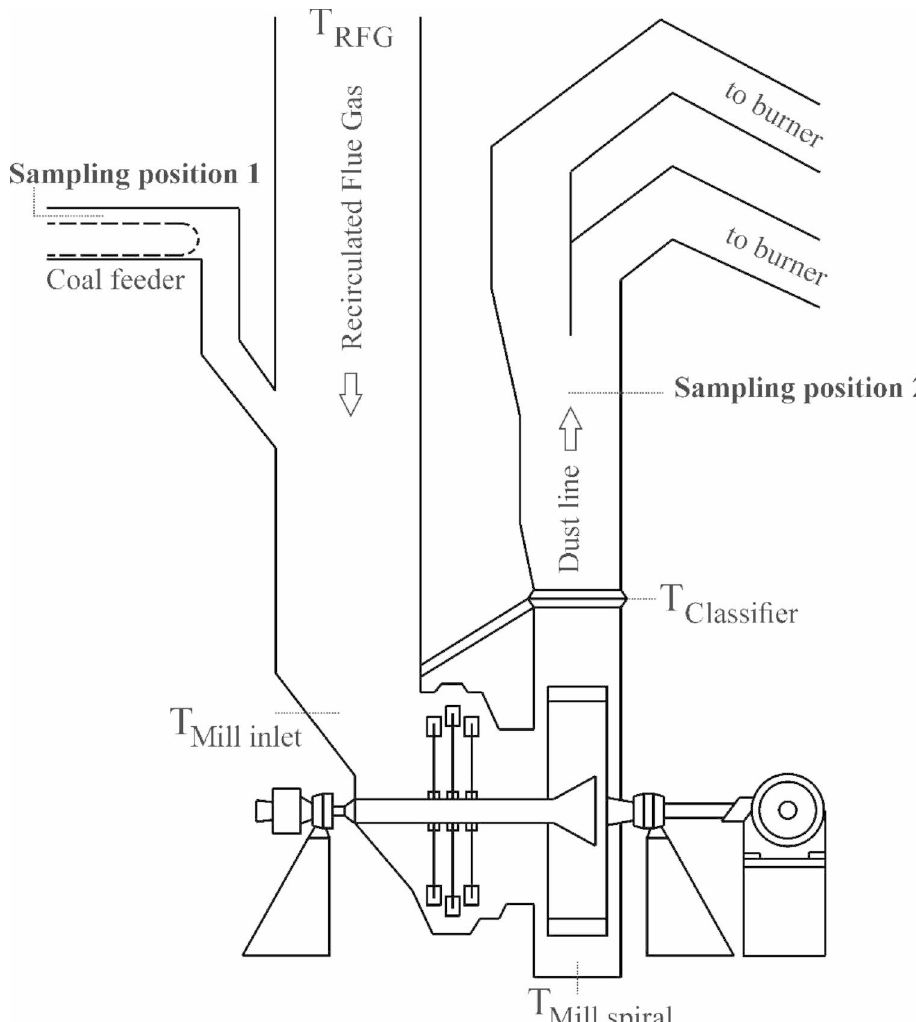
Fig. 2 Schematic beater wheel mill with measuring